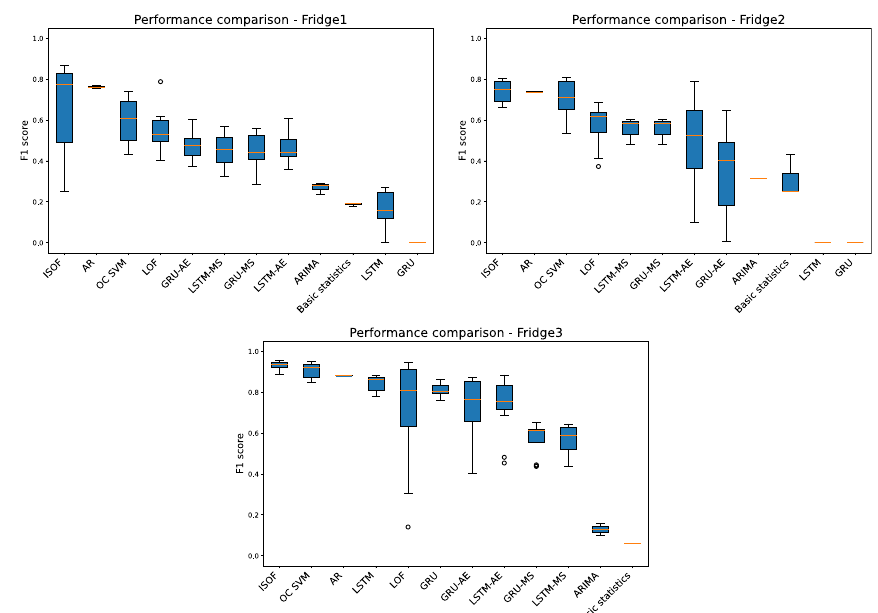
Fig. 7 Break down of the performance of all the algorithms by appliance. The methods are ordered by descending median value of the F 1